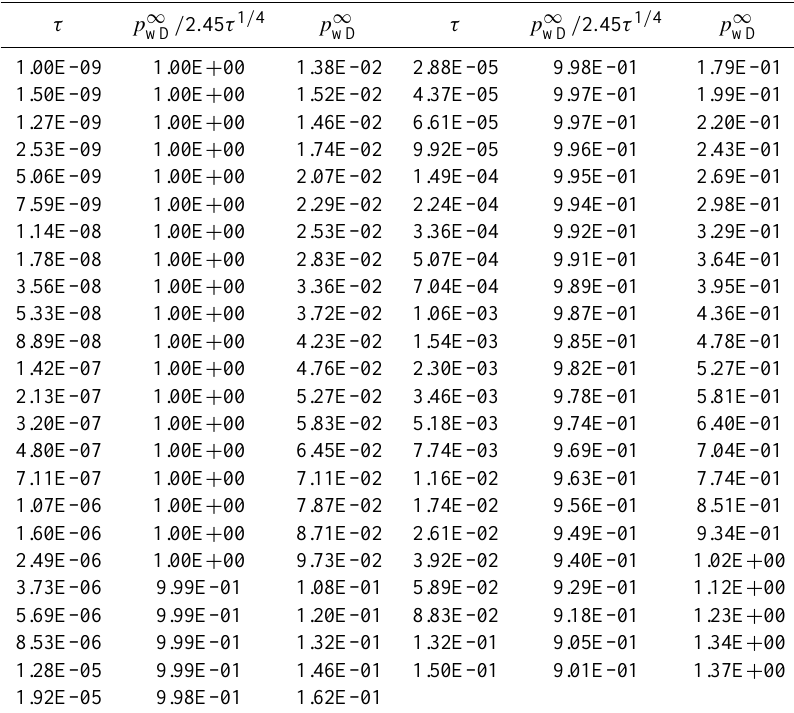
Table 1. Values of the master curve for normalized well pressure p ∞